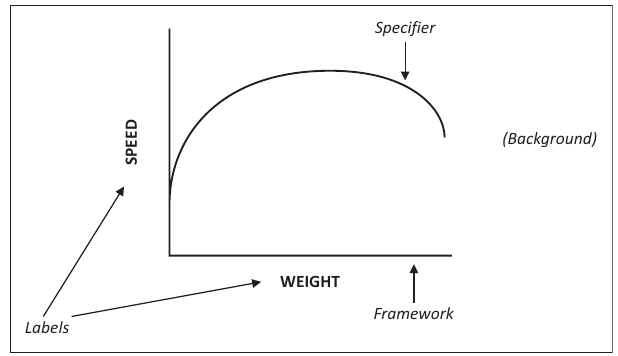
FIGURE 1: The basic-level constituent parts of a graph.